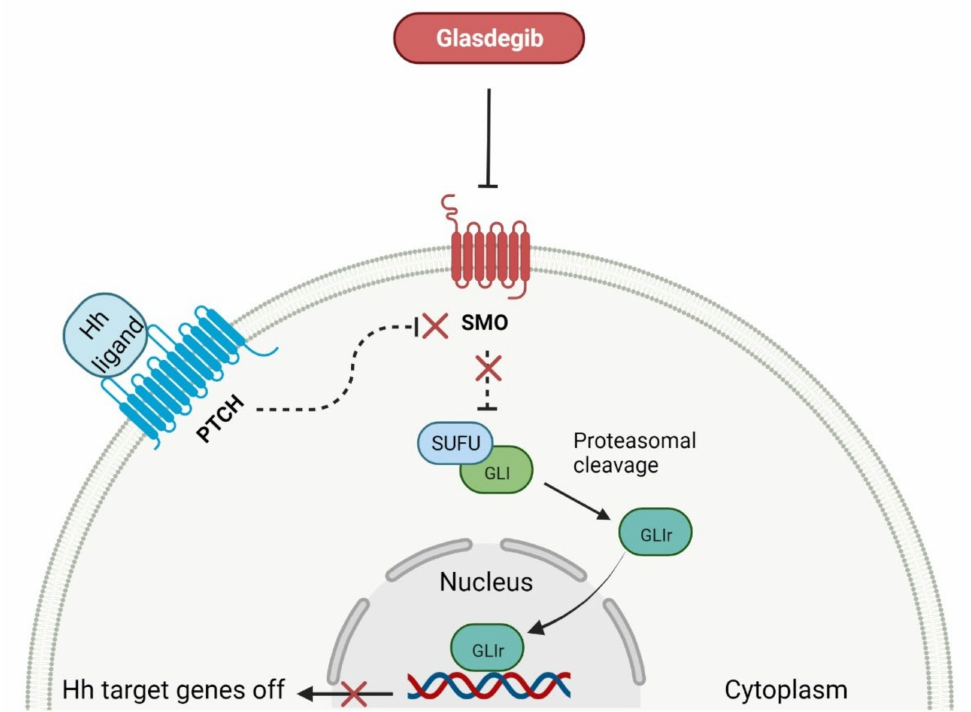
Figure 5. Glasdegib inhibition of the Hedgehog signaling pathway. HH : Hedgehog. PTCH : Patched receptor. SMO : smoothened receptor. SUFU : suppressor of fused protein. GLI : glioma-associated oncogene protein. GLIr : repressor form of GLI. Created with BioRender.com based on information in